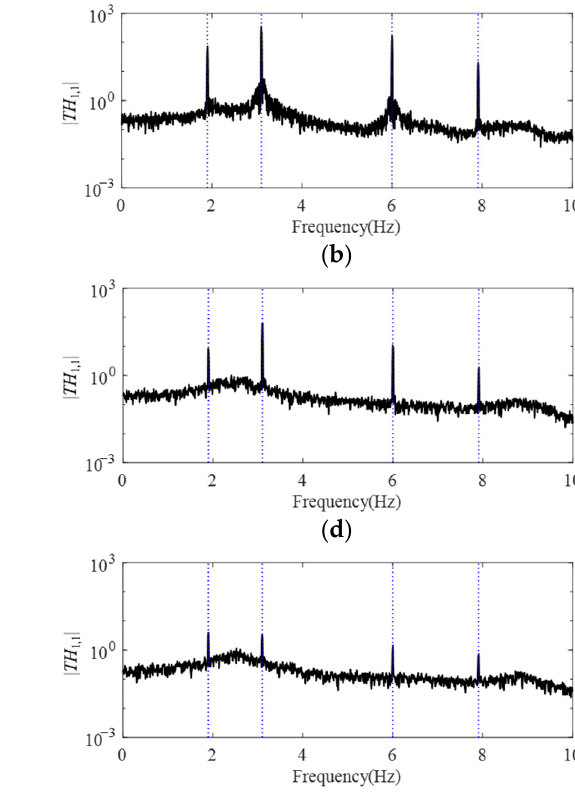
Figure 12. The virtual frequency response function with different period excitation amplitudes. ( a ) Conventional transmissibility (SNR = 20 dB); ( b ) delayed transmissibility (SNR = 20 dB); ( c ) conven- tional transmissibility (SNR = 0 dB); ( d ) delayed transmissibility (SNR = 0 dB); ( e ) conventional transmissibility (SNR = − 20 dB); ( f ) delayed transmissibility (SNR = − 20 dB).